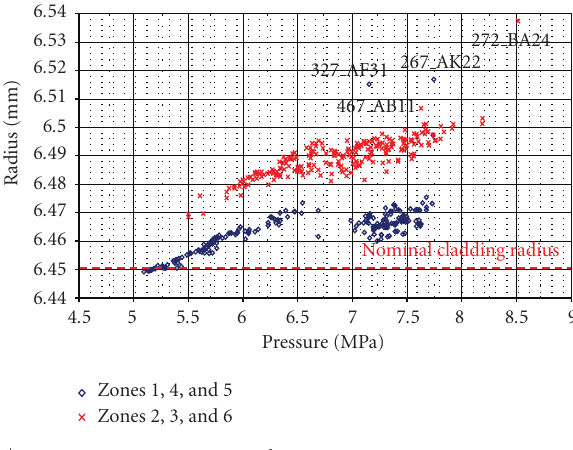
Figure 14: Fuel outer radius and cladding inner radius as a function of burnup; rod 267 BL21, and overall irradiation.